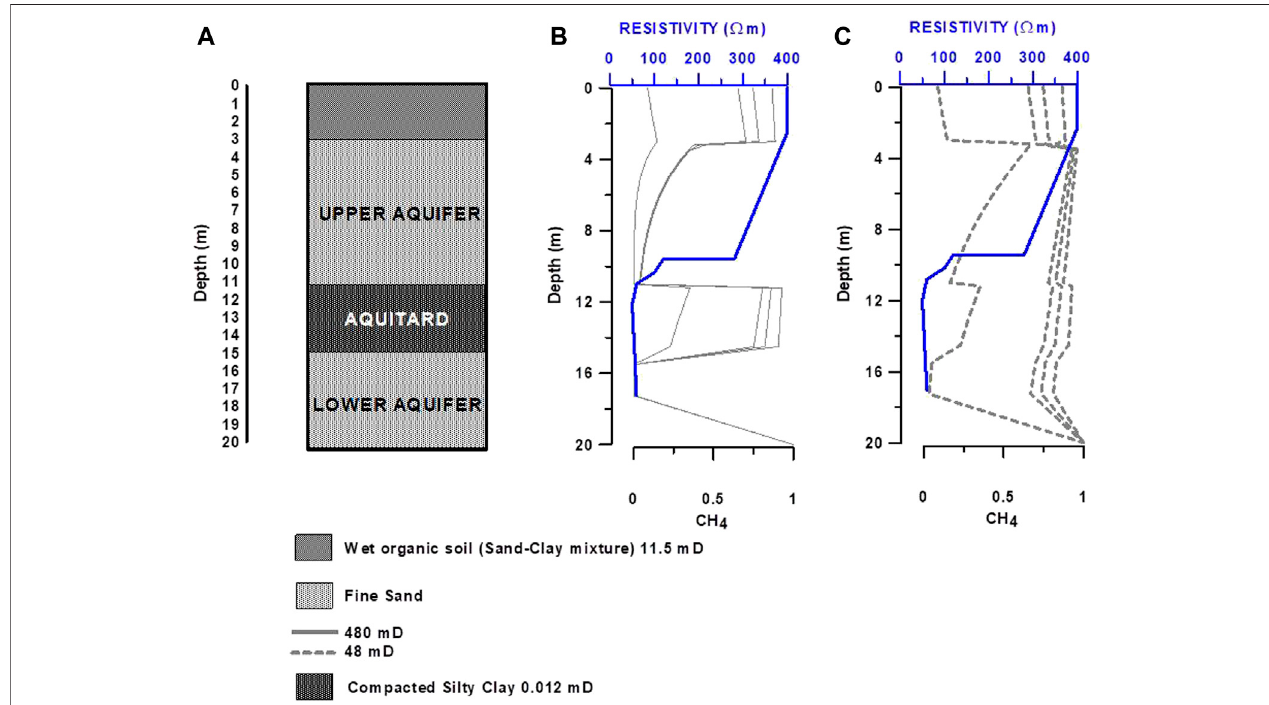
FIGURE 9 | Borehole BH8: (A) Arrangement of sedimentary layers for the control sequence featuring maximum permeability values according to Figure 4 . Resistivity log (solid blue line) obtained from the inverted electrical resistivity data at the cross-section of surveyed line L3 that includes BH8 ( Figure 1 ) is compared with the methane pro fi les for 1, 15, 30 and 120 days in (B) and (C) . (B) Comparison of the resistivity log with modeled methane pro fi les using permeability values of 480 mD (solidgraylines)forlayers2and4containingtheuncon fi nedandcon fi nedaquifers,respectively (C) Comparisonoftheresistivitylogwithmodeledmethanepro fi les using permeability values of 48 mD (dotted gray lines) for the fi ne sands containing the uncon fi ned aquifer.